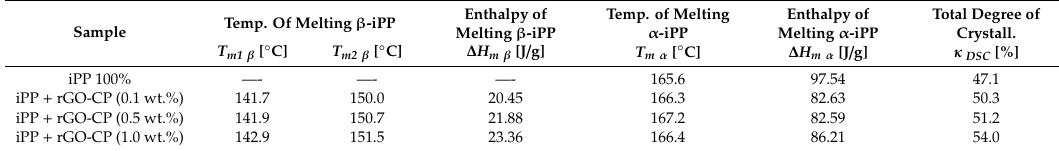
Table 3. Parameters determined on the basis of DSC measurements for gravity spun fibers.